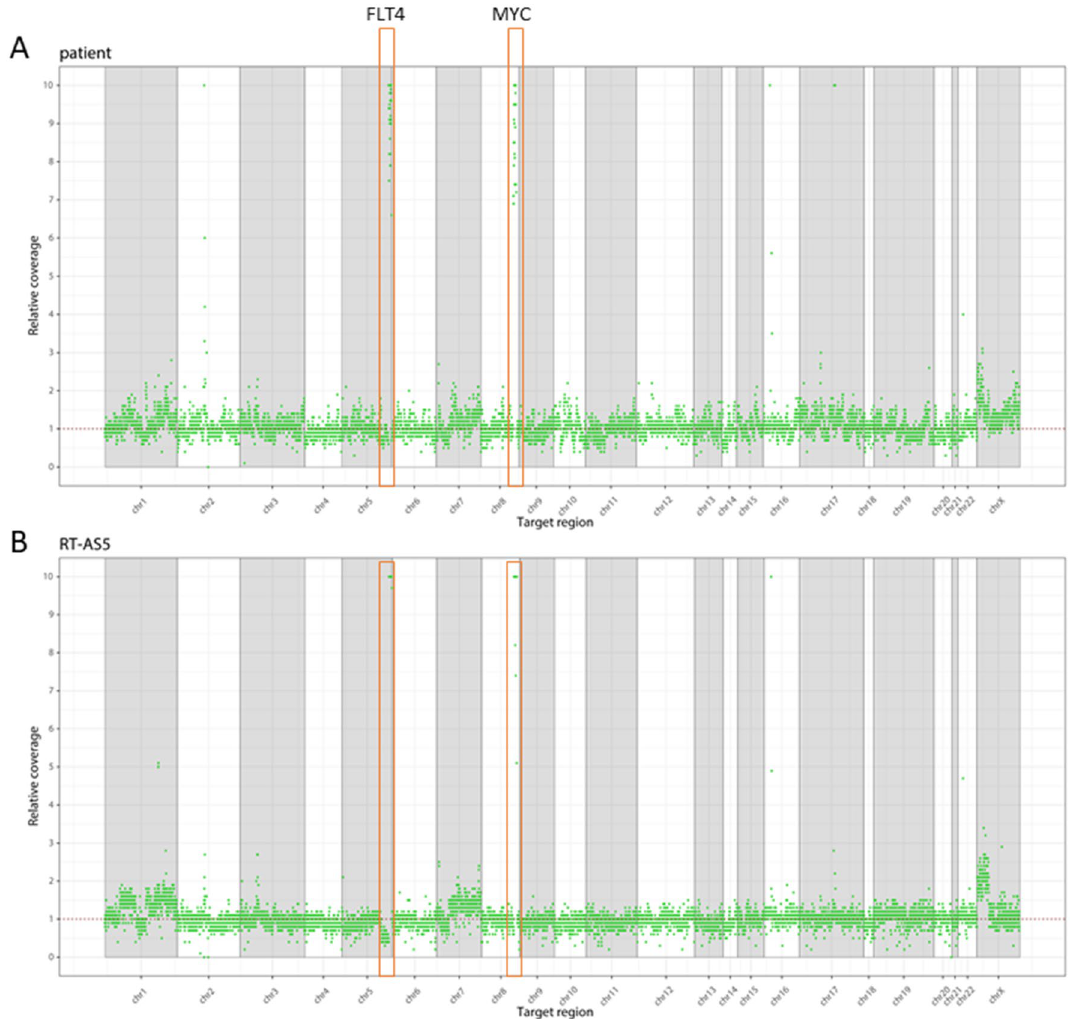
Figure 3. Copy number variations. Copy number variations in patient ( A ) and PDX ( B ) material, including amplifications of MYC and FLT4. Vertical bars represent chromosome 1–22, X and Y. A relative coverage of one corresponds to an equal number of copies as in the set of normal controls (2 copies of a gene region). A relative coverage of > 1 or < 1 indicates additional copies or loss of a copy, respectively.